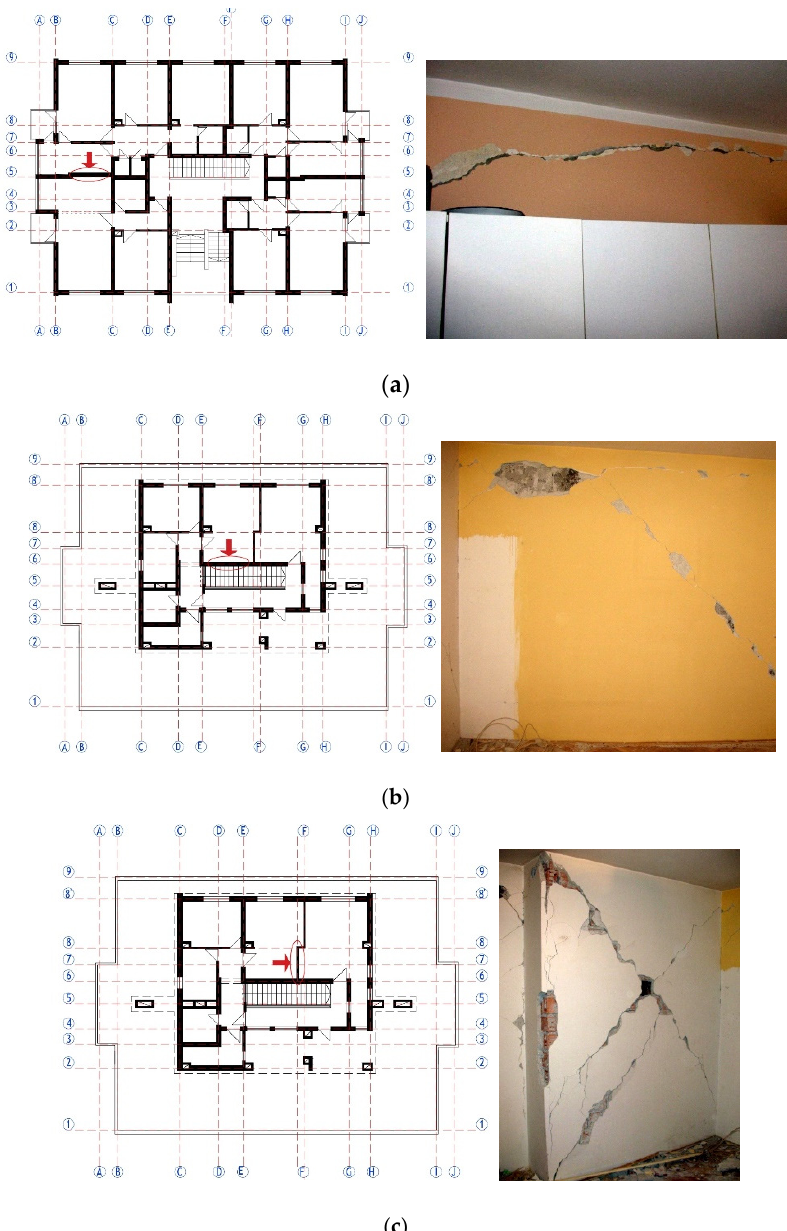
Figure 9. Earthquake damage patterns: ( a ) severe cracking in a longitudinal wall at the second floor level (gridline 5); ( b ) inclined cracking in a longitudinal wall at the top floor level (gridline 6 adjacent to the staircase) and ( c ) failure of a partition wall at the top floor level.